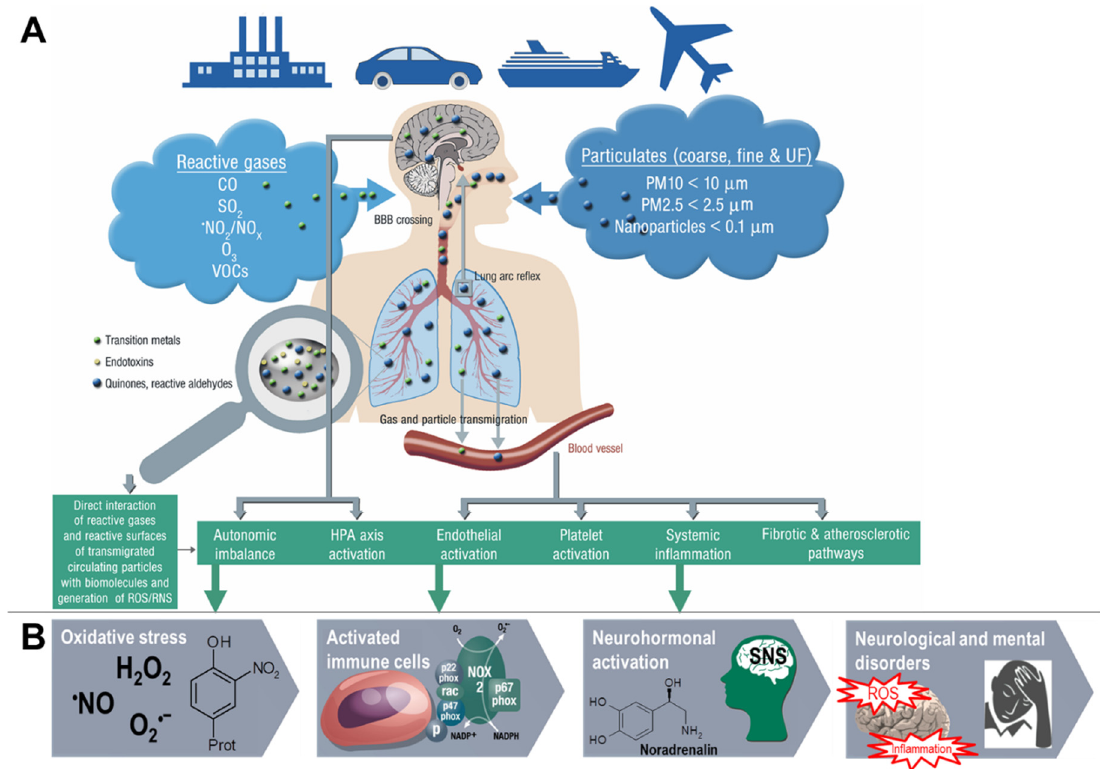
Figure 3. Summary of pathophysiological mechanisms by which air pollutants cause